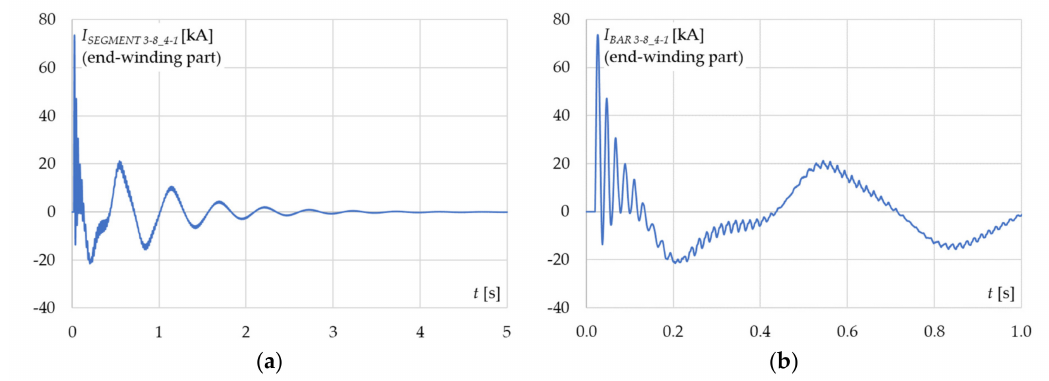
Figure 20. Waveforms of induced current in rotor’s circuited segment 3-8_4-1 during out-of-phase synchronization of − 120 ◦ in ( a ) the scope of the considered calculation time and ( b ) the first second.